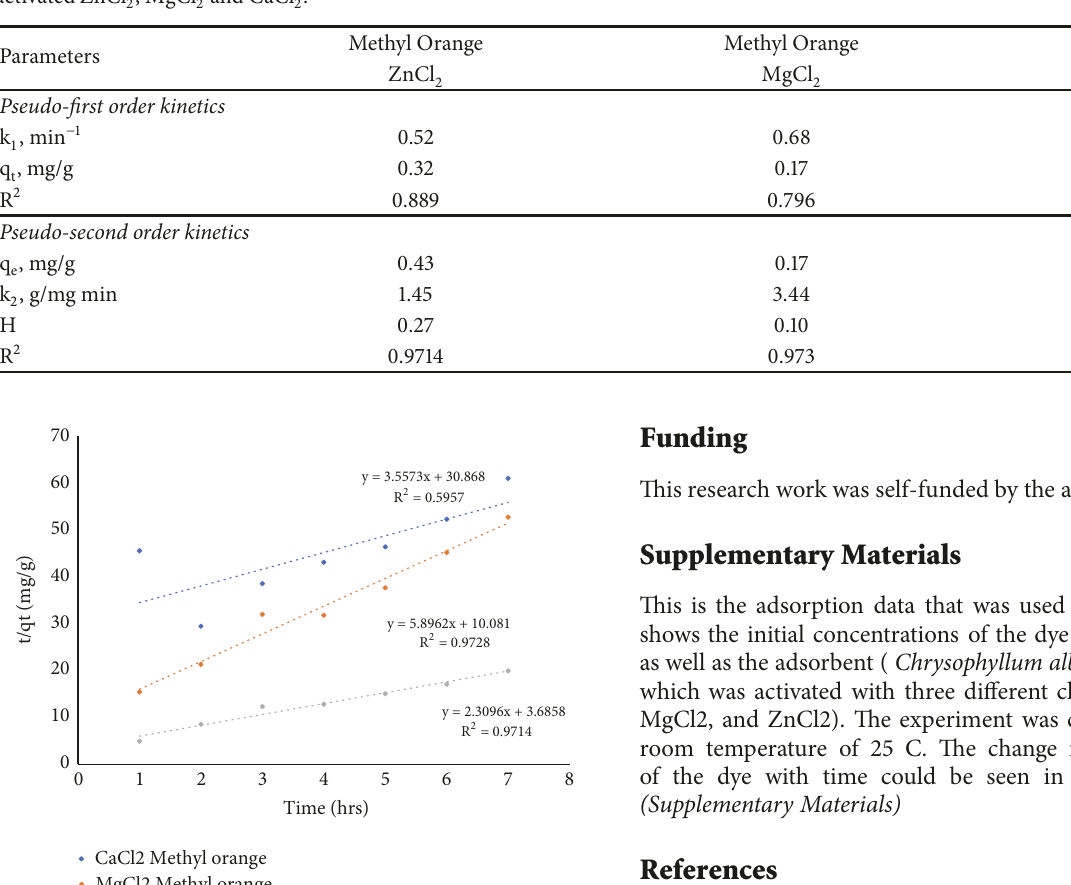
Table 3: The calculated parameters of the pseudo-first-order and pseudo-second order models for the adsorption methyl orange using activated ZnCl 2 , MgCl 2 and CaCl 2 .